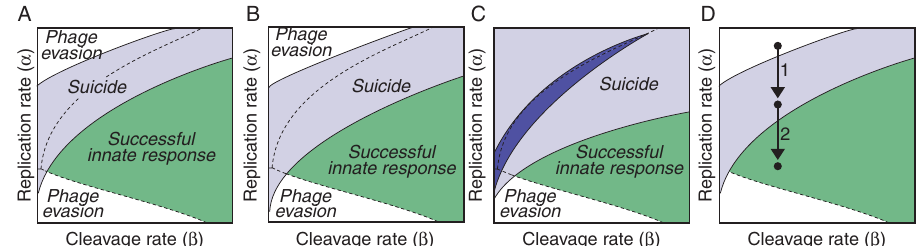
Fig.3|Coordinationofinnateimmuneresponsesinbacterialcells.A Numerical simulations of Model 2 show that bacterial suicide could take place in a region of the infection space that overlaps with fast phages. This implies that Abi systems could neutralize phages that are not susceptible to restriction nucleases. B The suicide region produced by an alternative Abi system (described by equations (4)) issimilartothatshownin( A ). C Changingthevaluesoftheparametersofequation (3)inModel2givesraisetodifferentsuicideregions(showninclearanddarkblue,